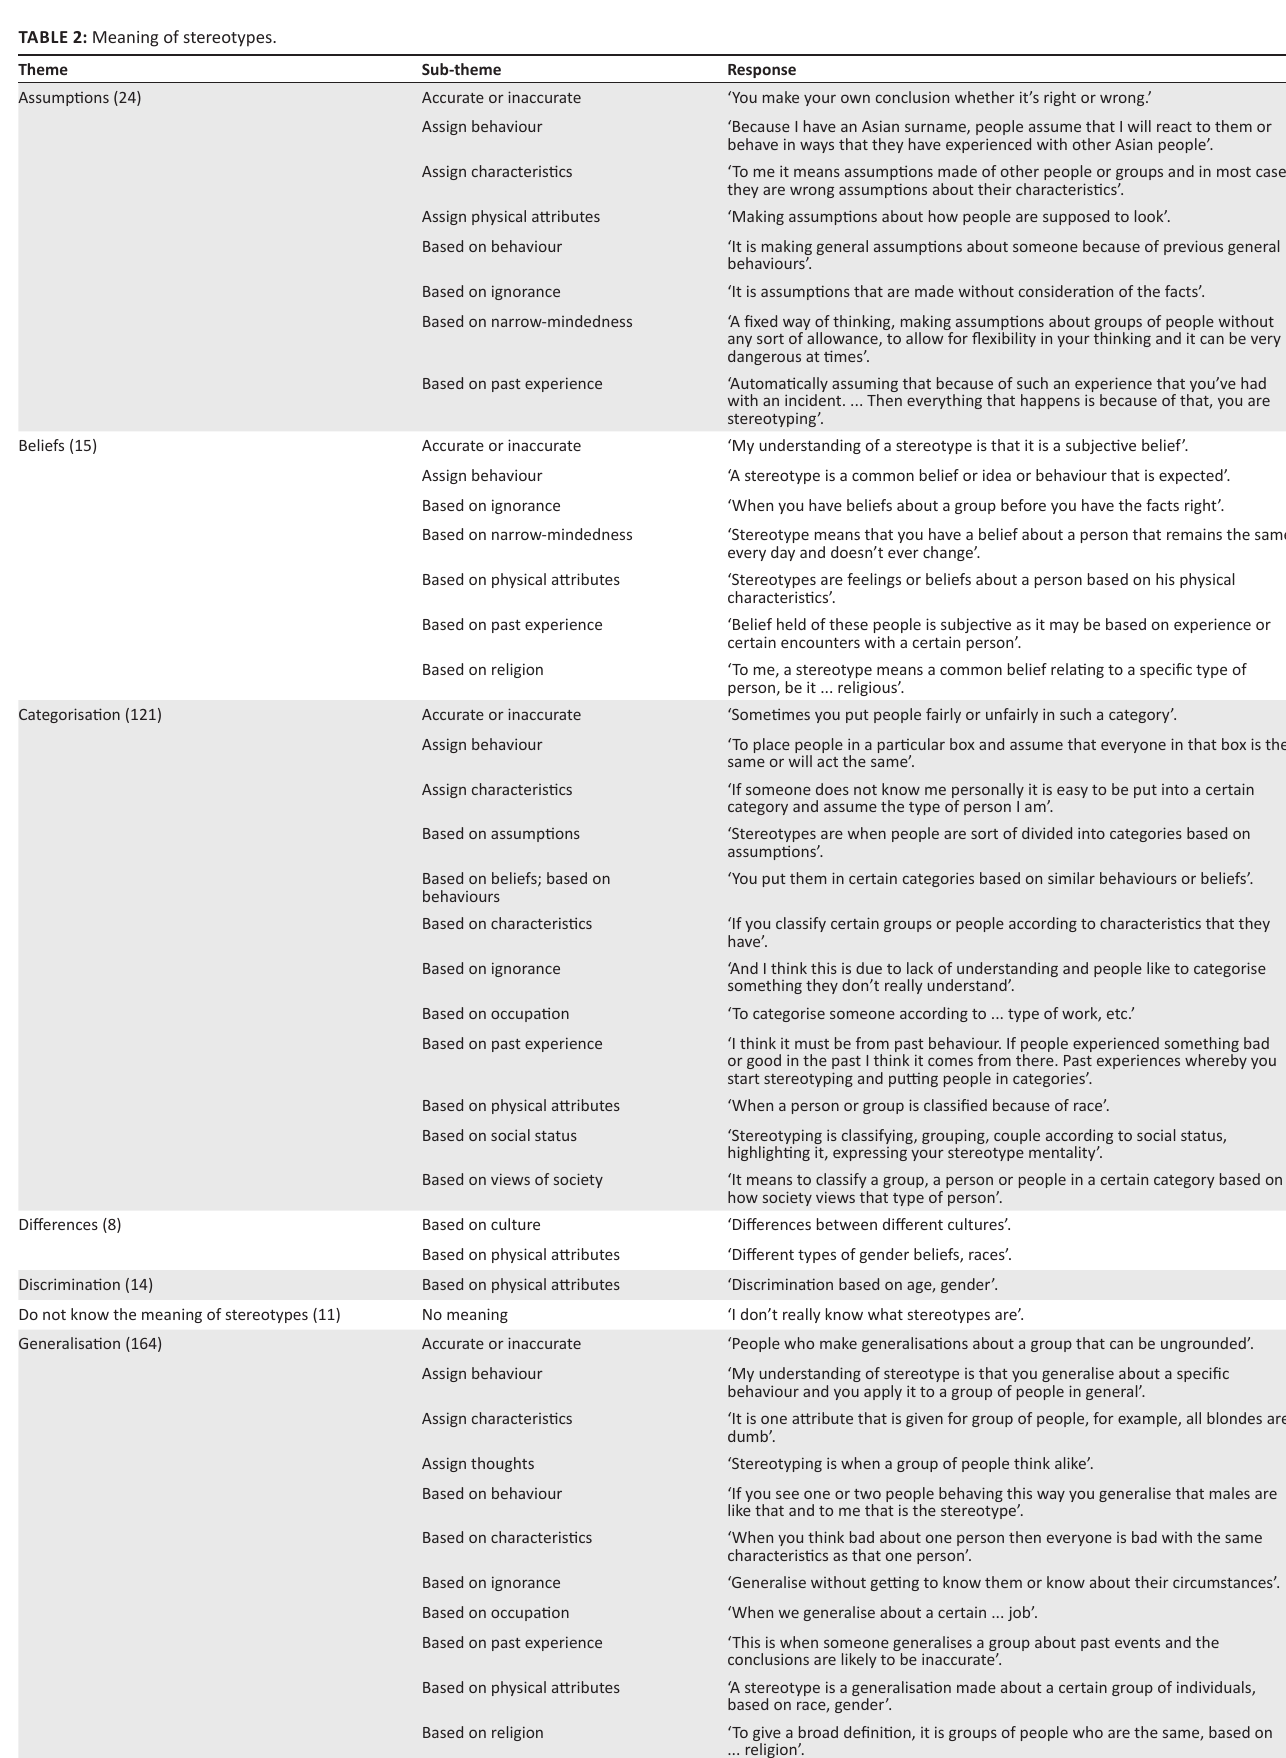
TABLE 2: Meaning of